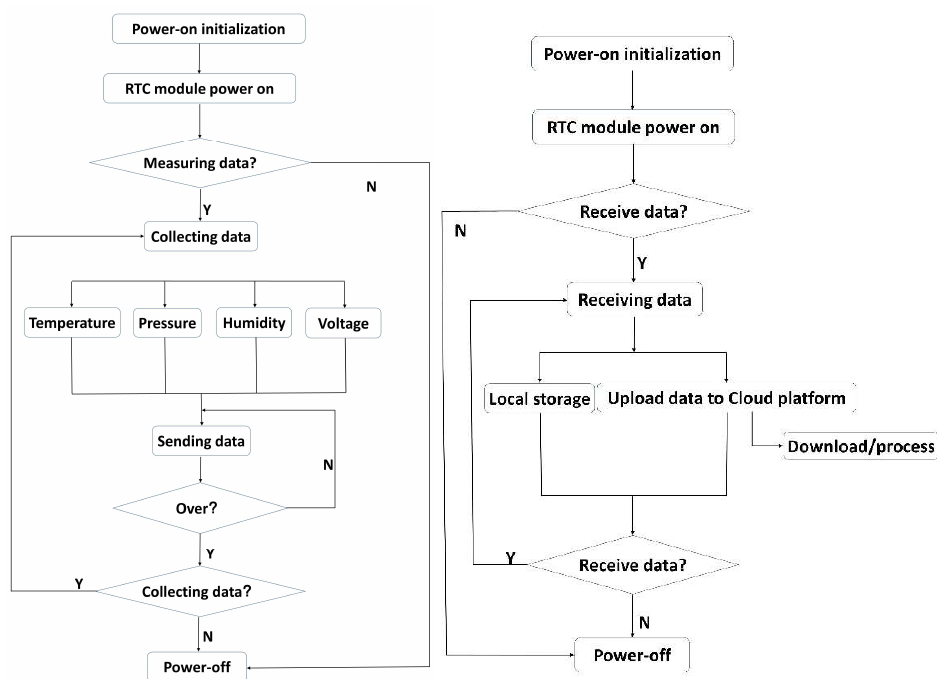
Figure 4. System workflow diagram for glacier internal unit ( left ) and surface base station ( right ). saving control circuit is consistent with the glacier internal measurement unit, and the local storage and data uploading to the cloud platform are added to this